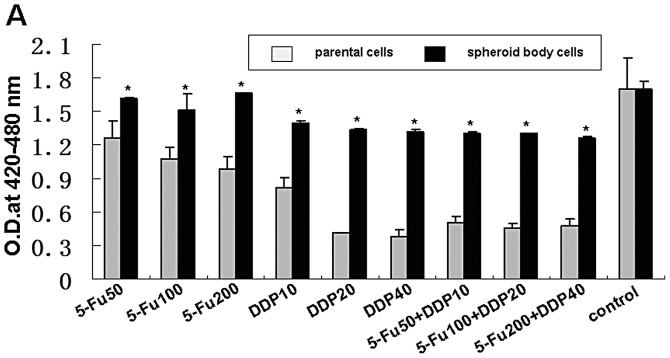
Spheroid-forming cells proliferate extensively and possess resistance ability to conventional chemotherapeutics in vitro. The MKN-45 spheroid body-forming cells showed a drug resistance phenotype. The parental cells and spheroid body-forming cells were treated with different concentrations (μg/ml) of 5-Fu and DDP at the beginning of plating for (A) 24 or (B) 48 h. Cell survival was determined by MTT assay (#p>0.05; *p<0.01).